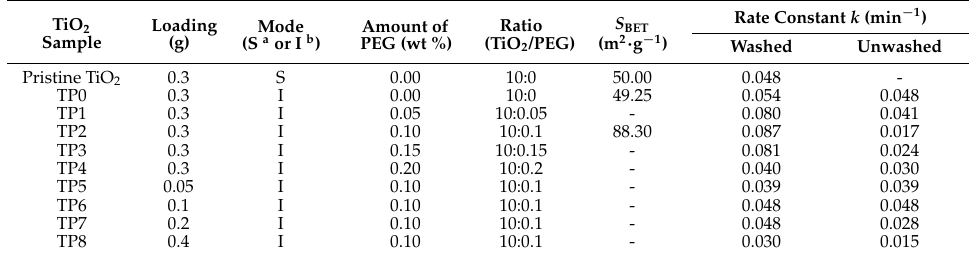
Table 1. The experimental condition and pseudo first order rate constant of immobilized TiO 2 and the control sample in degrading methylene blue (MB)